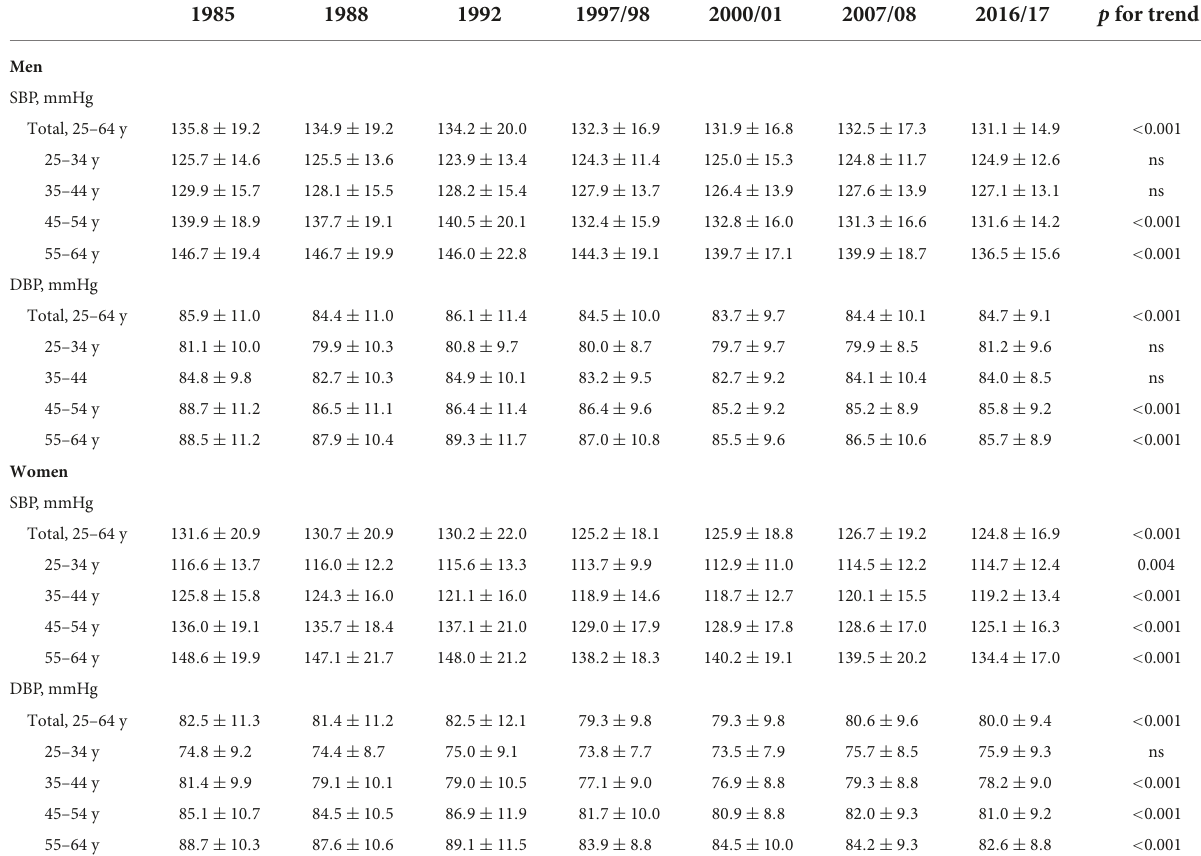
TABLE 2 Blood pressure (mean ± SD) between 1985 and 2016/17 in six districts of the